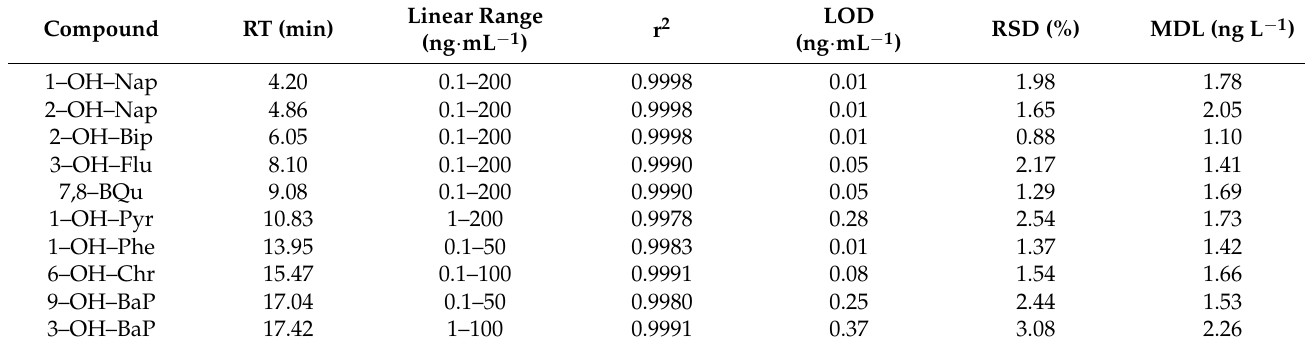
Table 3. RT, linear range, correlation coefficients (r 2 ), LOD, LOQ and instrument RSD ( n = 7) of each compound.